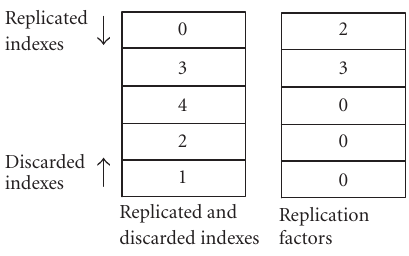
Figure 9: Contents of memories after the RSR method with particle allocation with arranged indexes.